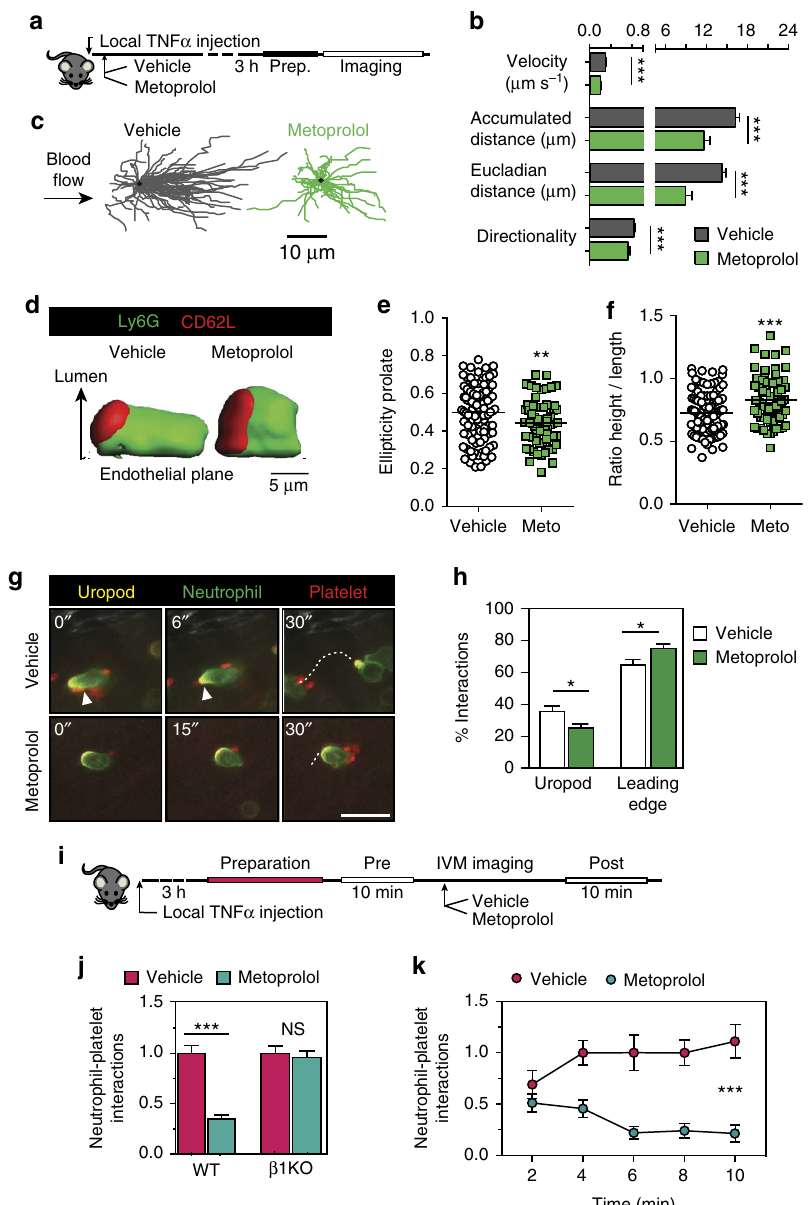
Figure 5 | Metoprolol stuns neutrophils and prevents interactions with platelets. ( a ) Experimental design: WTmice receiving TNF a were randomized to receive i.v. metoprolol or vehicle before analysis of cremaster muscle vessels by 2D and 3D intravital microscopy. ( b ) Quantification of parameters related to two-dimensional intravascular motility; n ¼ 54–141 cells from 3 to 4 mice. ( c ) Representative tracks of crawling neutrophils within inflamed vessels. ( d ) 3D reconstructions of representative neutrophils within live vessels of saline-treated and metoprolol-treated mice (red, uropod; green, cell body). ( e , f ) Quantification of 3D parameters, indicating reduced elongation (prolate ellipticity) and enhanced projection of recruited neutrophils into the luminal space (height-to-length ratio); n ¼ 68–105 cells from 3 to 4 mice. ( g , h ) Representative time-lapse images and percentage of interactions of platelets (CD41, red) with the polarized neutrophil uropod (CD62L, yellow) or leading edge (Ly6G, green); n ¼ 28–29 vessels from 3 to 4 mice. White arrowheads indicate interactions with the uropod and the dotted line the displacement of the cells during 30s. Scale bar, 10 m m. ( i ) Protocol scheme for evaluating the acute inhibitory effect of metoprolol on activated and polarized neutrophils on WT and AdrbB1- knockout ( b 1KO) mice. ( j ) Absolute neutrophil–platelet intravascular interactions in WT and b 1KO mice. NS, stands for non-significant. ( k ) Temporal neutrophil–platelet interaction inhibition in WT mice after administration with i.v. metoprolol. Data are means ± s.e.m. * P o 0.05; ** P o 0.01; *** P o 0.001, determined by unpaired Student’s t -test for each